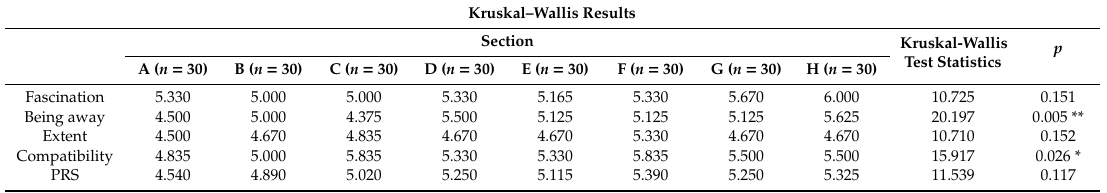
Table A5. PRSS Kruskal–Wallis